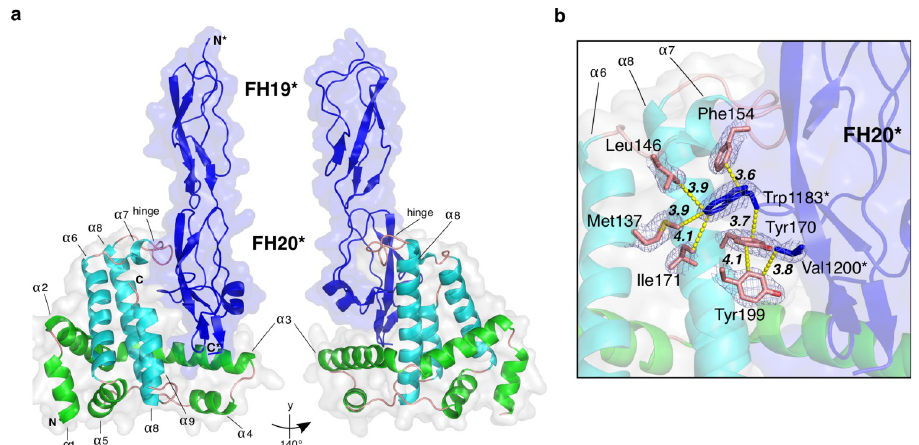
Fig 1. 2.2 Å crystal structure of BhFhbA in complex with FH19-20. (a) A cartoon representation of the BhFhbA: FH19-20 complex. BhFhbA forms a bundle of nine α -helices resembling an arc-like or L-shaped structure. α -helices 1–5 (in green) wrap around the core formed by α -helices 6–9 (in teal). The connecting loop of α -helices 7 and 8 create a hinge-like structure close to C-terminus of BhFhbA. Together the L-shaped cavity ( α -helices 3, 8 and 9) and the hinge-loop coordinate the binding of FH20 (in blue). (b) Close-up of the binding site with key sidechains represented as sticks. FH20 Trp1183 and Val1200 (in blue, indicated by � ) coordinate binding by a group of hydrophobic residues in BhFhbA. Trp1183 of FH20 is inserted to the hydrophobic pocket formed by BhFhbA Phe154, Met137, I171 and Tyr170. Further, FH20 Val1200 is within van der Waals distance of BhFhbA Tyr170 and Tyr199. 2Fo-Fc density, contoured at 1 σ , is shown around the